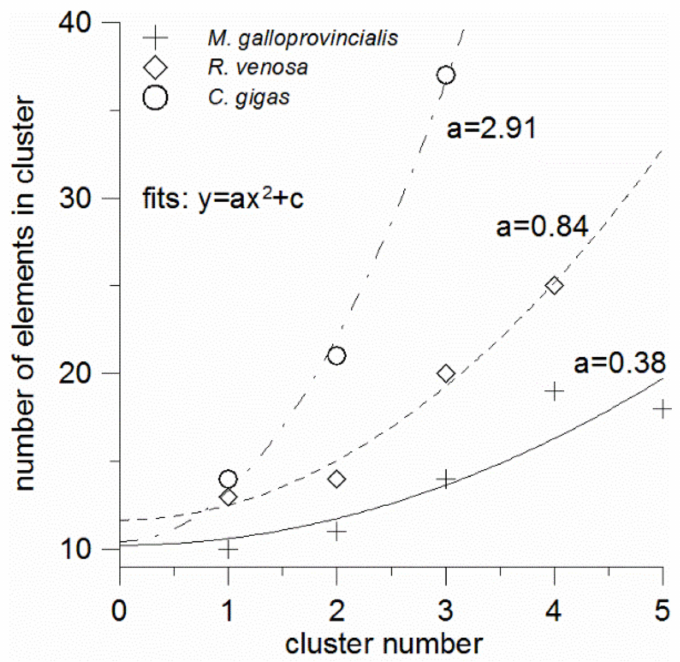
Figure 4. Number of elements in optimal non-overlapping clusters against the cluster number for the three mollusk species (legend). Lines: quadratic fits y = ax 2 + c. The quadratic term coefficients are shown beside each fit